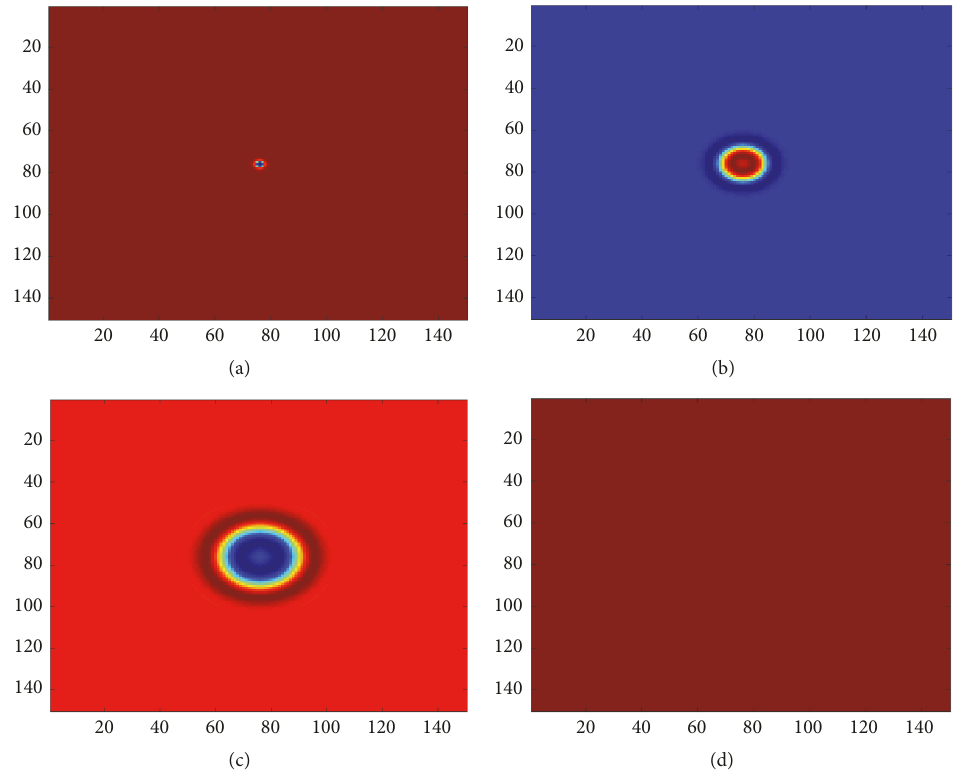
Figure 3: The snapshots of spatial distribution of membrane potential with color scale for neurons in the square array network for 𝑘 = 0.5 and 𝐷 = 1 at (a) 𝑡 = 2 time units, (b) 𝑡 = 20 time units, (c) 𝑡 = 100 time units, and (d) 𝑡 = 200 time